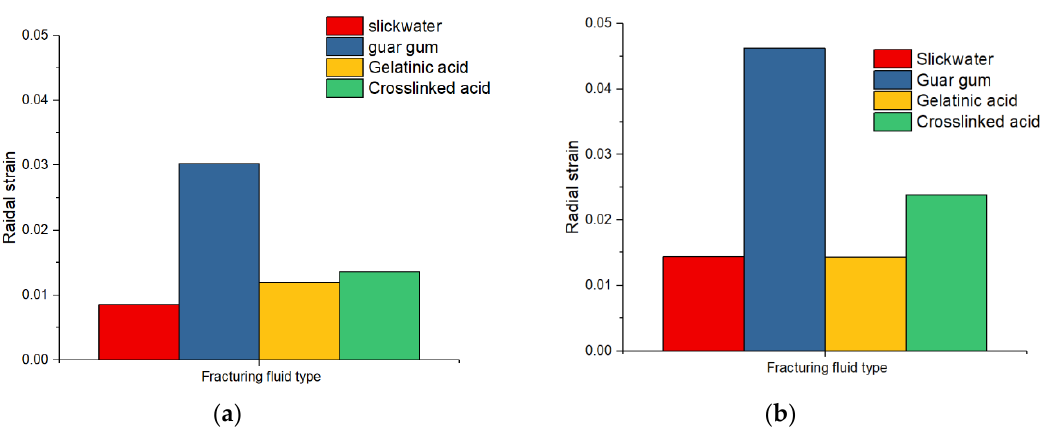
Figure 6. Radial strain with different fracturing fluids and flow rate: ( a ) 0.02 mL/s; ( b ) 0.07 mL/s.